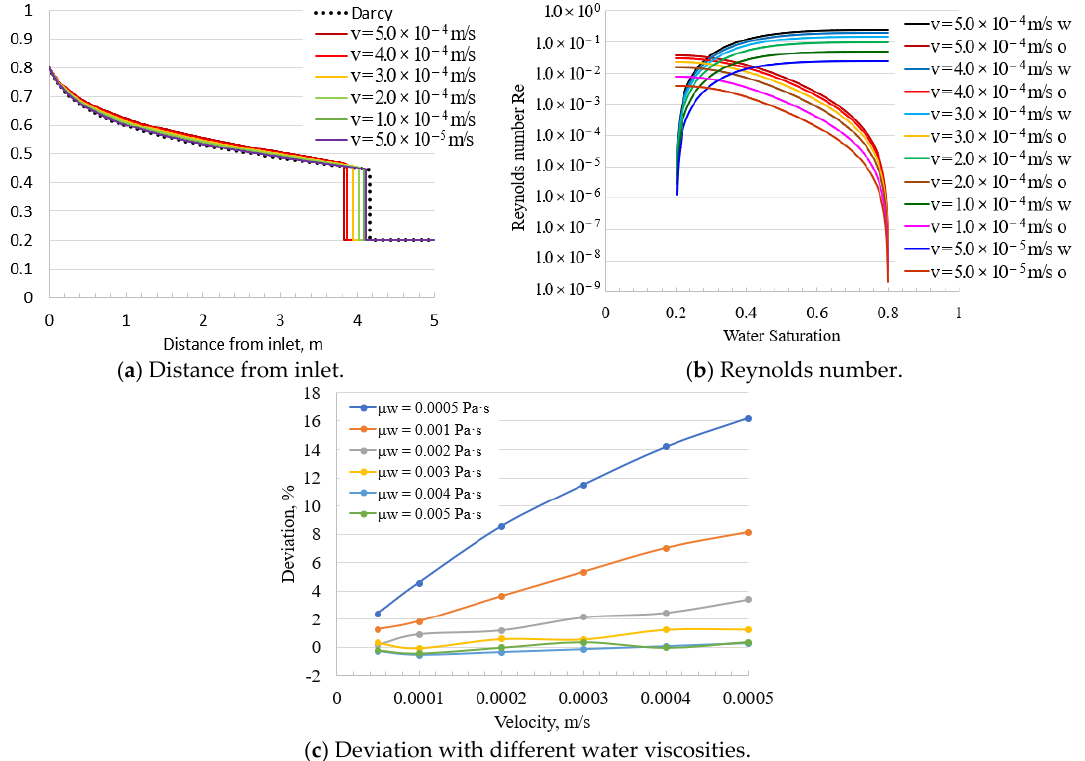
Figure 12. Comparison of Darcy model vs. Barree – Conway model for different flow velocities.